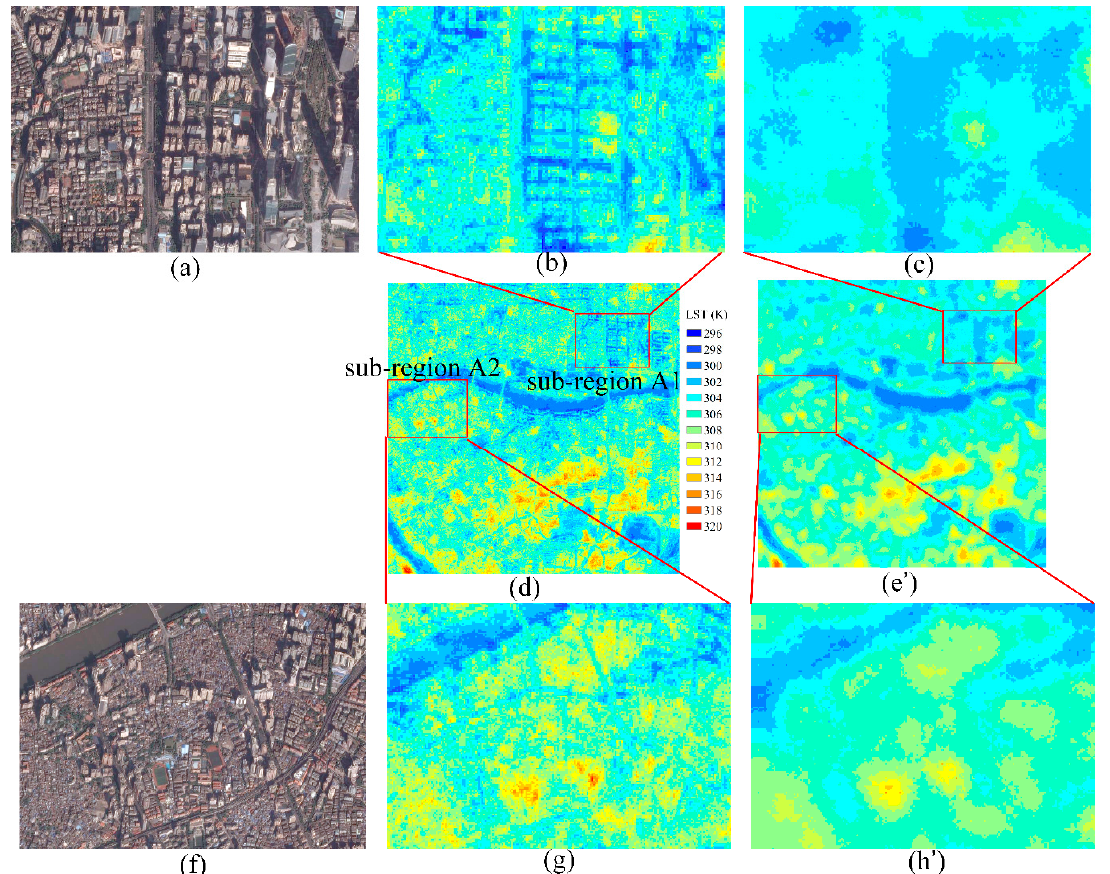
Figure 12. Downscaled LSTs of the RFATPK and the TsHARP for region A. ( a , f ) High-spatial resolution images from Google map; ( b , c ) 10 m RFATPK and TsHARP downscaled LSTs for subregion A1; ( d , e ) 10 m RFATPK and TsHARP downscaled LSTs for region A; ( g , h ) 10 m RFATPK and TsHARP downscaled LSTs for subregion